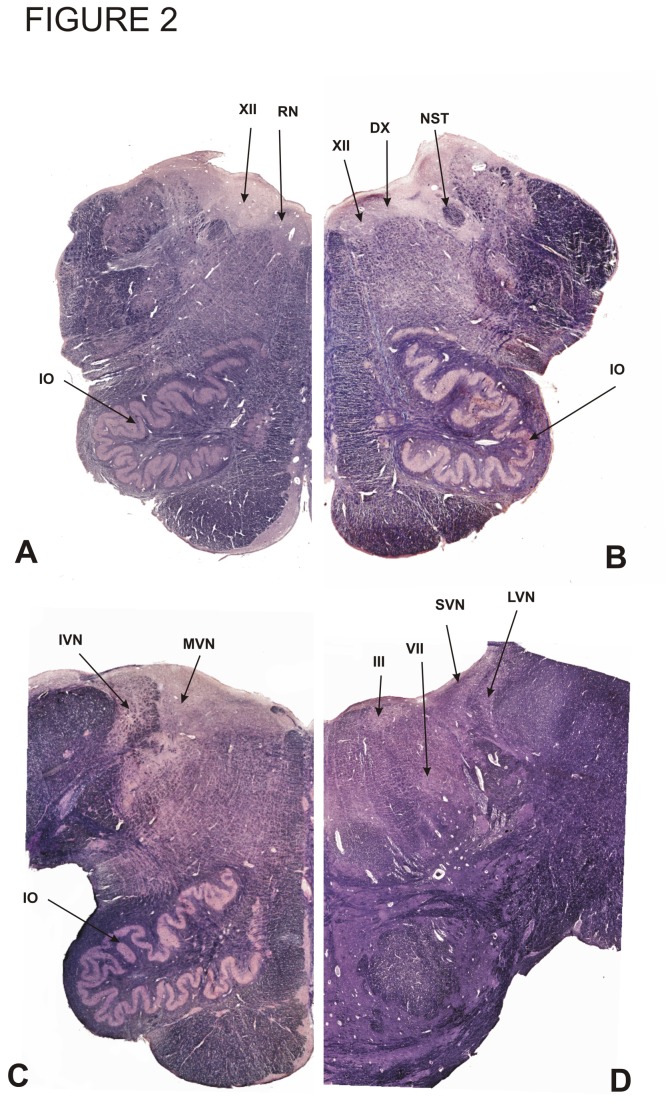
Hemisections of medulla oblongata.Four levels of medulla oblongata (A,B,C,D), stained with a Nissl/Myelin technique, with the localization of the different nuclei studied in the present paper are showed.